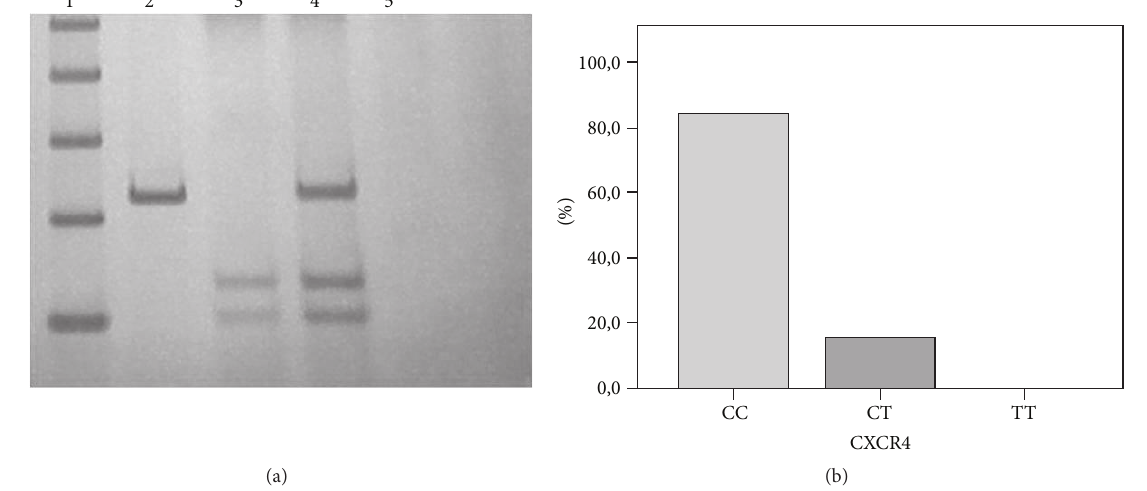
Figure 1: CXCR4 rs2228014 (C/T) genetic polymorphism. (a) Electrophoretic profile of rs2228014 (C/T). BccI restriction enzyme was used for 4h at 37 ∘ C. Polyacrylamide gel 10% stained with silver nitrate. Lane 1, Ladder DNA fragment marker of 100bp; Lane 2, PCR product of 236 pb; Lane 3, wild-type homozygous genotype of 133 pb and 103pb (CC); Lane 4, heterozygous genotype of 236 pb, 133pb, and 103 pb (CT); Lane 5, blank reaction or negative control (reaction without DNA). (b) Genotype distribution for CXCR4 rs2228014 in breast cancer